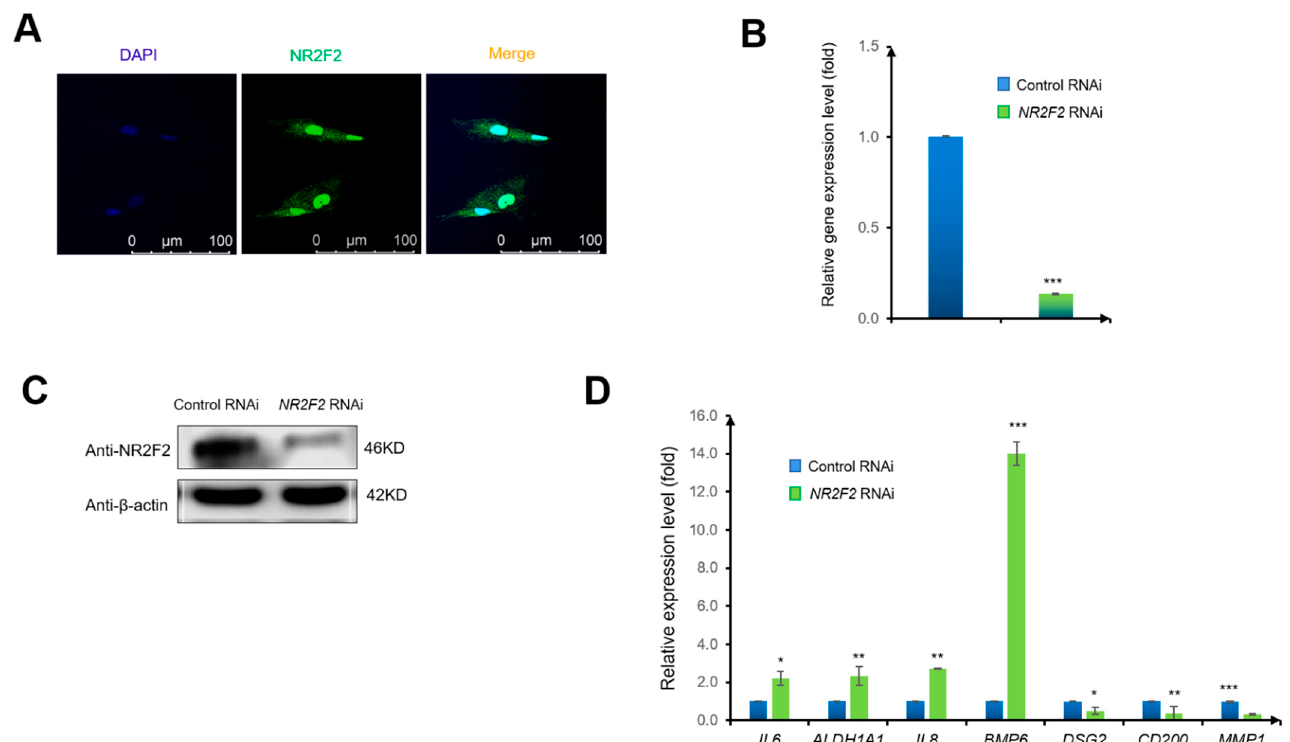
Figure 1. NR2F2 knockdown affects key factors of immunity and differentiation in WJ-MSCs. ( A ) Immunocytochemical staining for DAPI (blue) and NR2F2 (green). Images were taken at 40× magnification. Scale bar = 100 µM. ( B ) NR2F2 mRNA levels (relative to β -actin) in WJ-MSCs transfected with control siRNA (control siRNA), or NR2F2 siRNA (NR2F2 RNAi) were analyzed by qPCR. The data were analyzed by the δ - δ -Ct method, and the genes in control siRNA-transfected WJ-MSCs were set to 1. ( C ) Western blot analysis of NR2F2 protein levels in WJ-MSCs. ( D ) Relative gene expression changes of IL6 , ALDH1A1 , IL8 , BMP6 , DSG2 , CD200, and MMP1 genes upon NR2F2 depletion (control RNAi as control). * p ≤ 0.05, ** p ≤ 0.01, *** p ≤ 0.001.